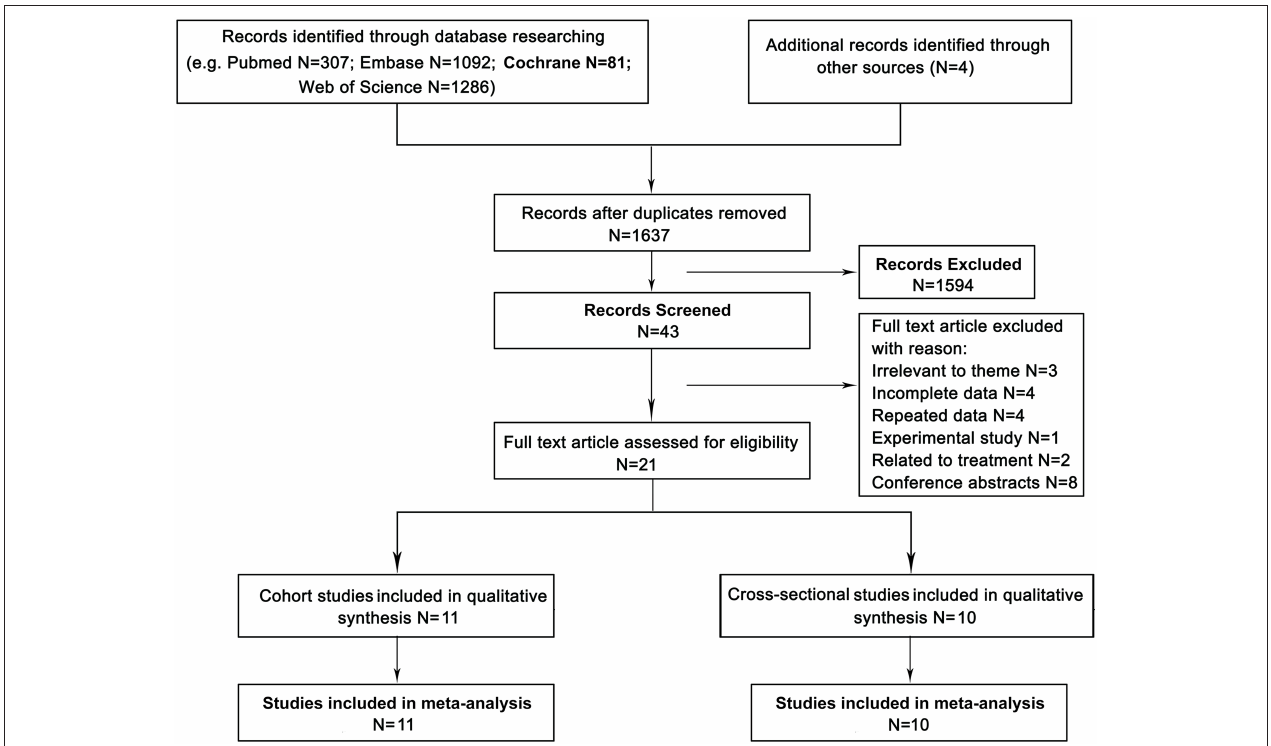
FIGURE 1 | Flow-chart of studies’ selection